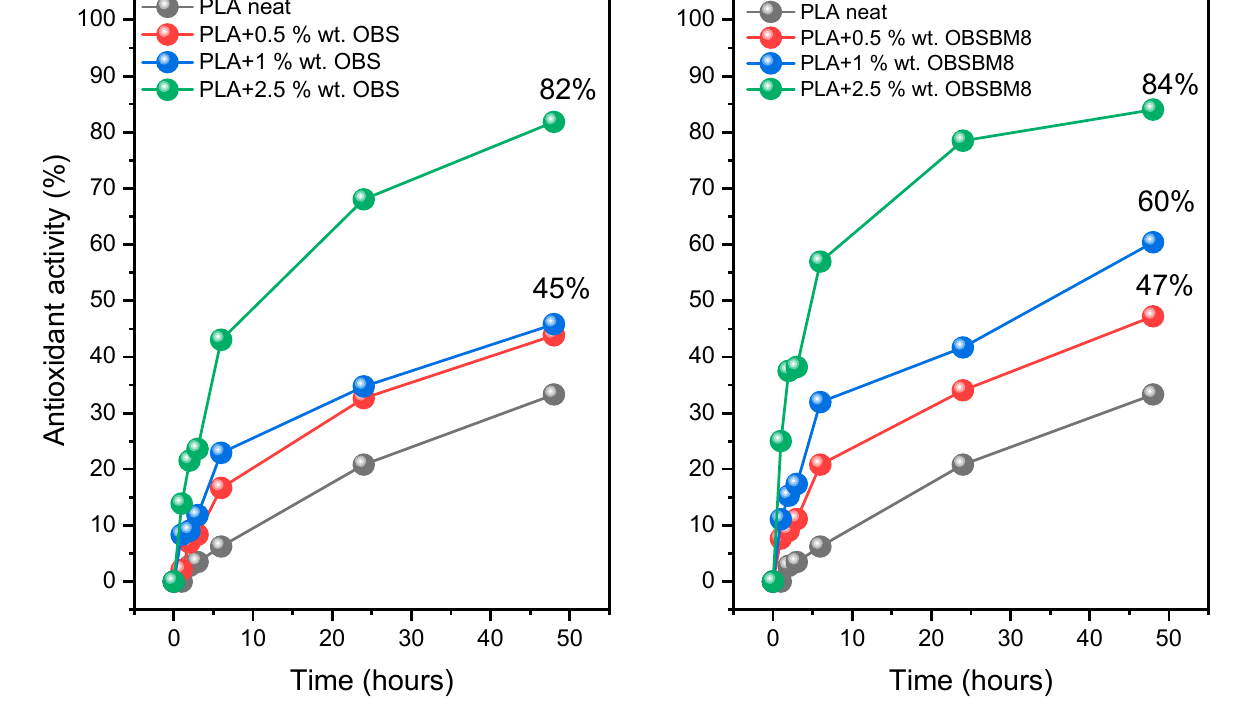
Figure 8. Effect of time, size, and concentration of lignin on the antioxidant activity of PLA.